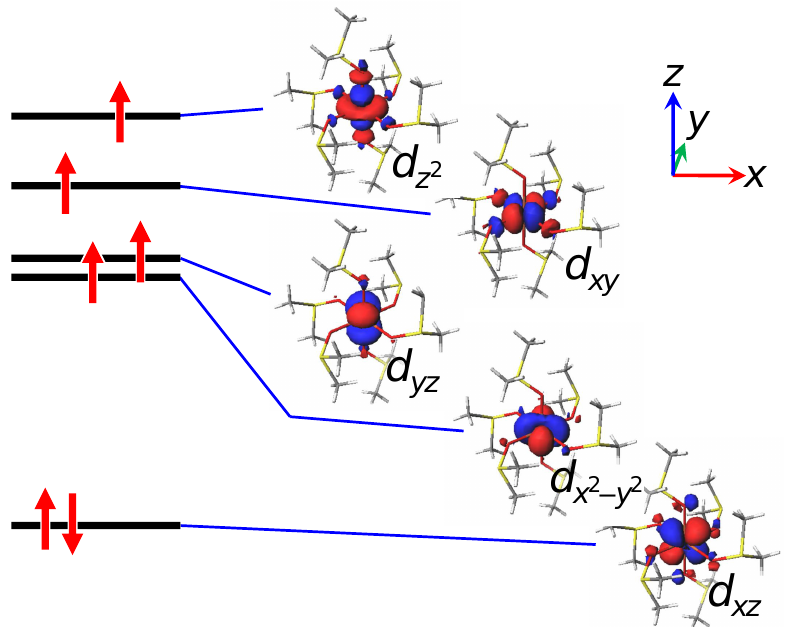
Figure 5. Energy levels and molecular orbitals obtained by the DFT calculation